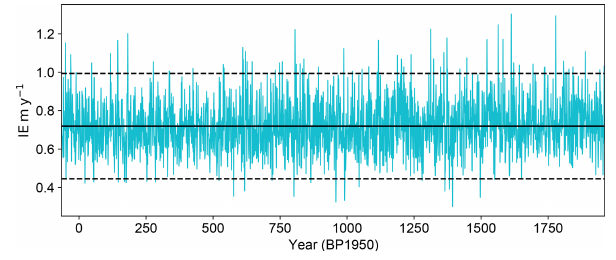
Figure 16. Time series for DJFMAM (warm season) annual sea salts concentration. Solid black line indicates the 2000-year mean value. Dashed black lines indicate ± 2 σ values.